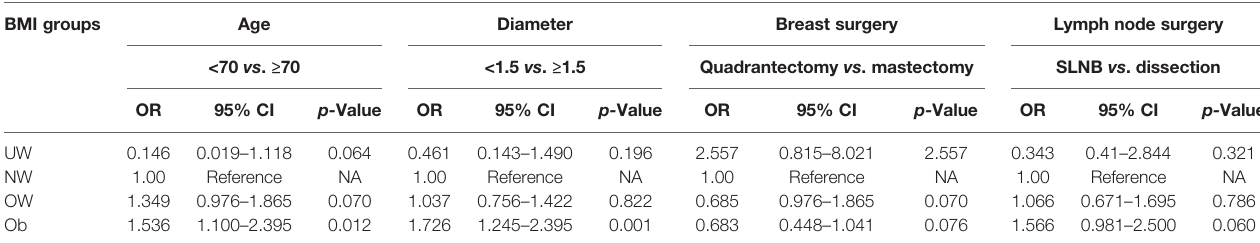
TABLE 7 | Case-only ORs and 95% CIs from logistic regression models of the associations among age, T size, breast surgery, axillary surgery, and BMI. BMI groups Age Diameter Breast surgery <70 vs . ≥ 70 <1.5 vs . ≥ 1.5 Quadrantectomy vs . mastectomy SLNB vs .